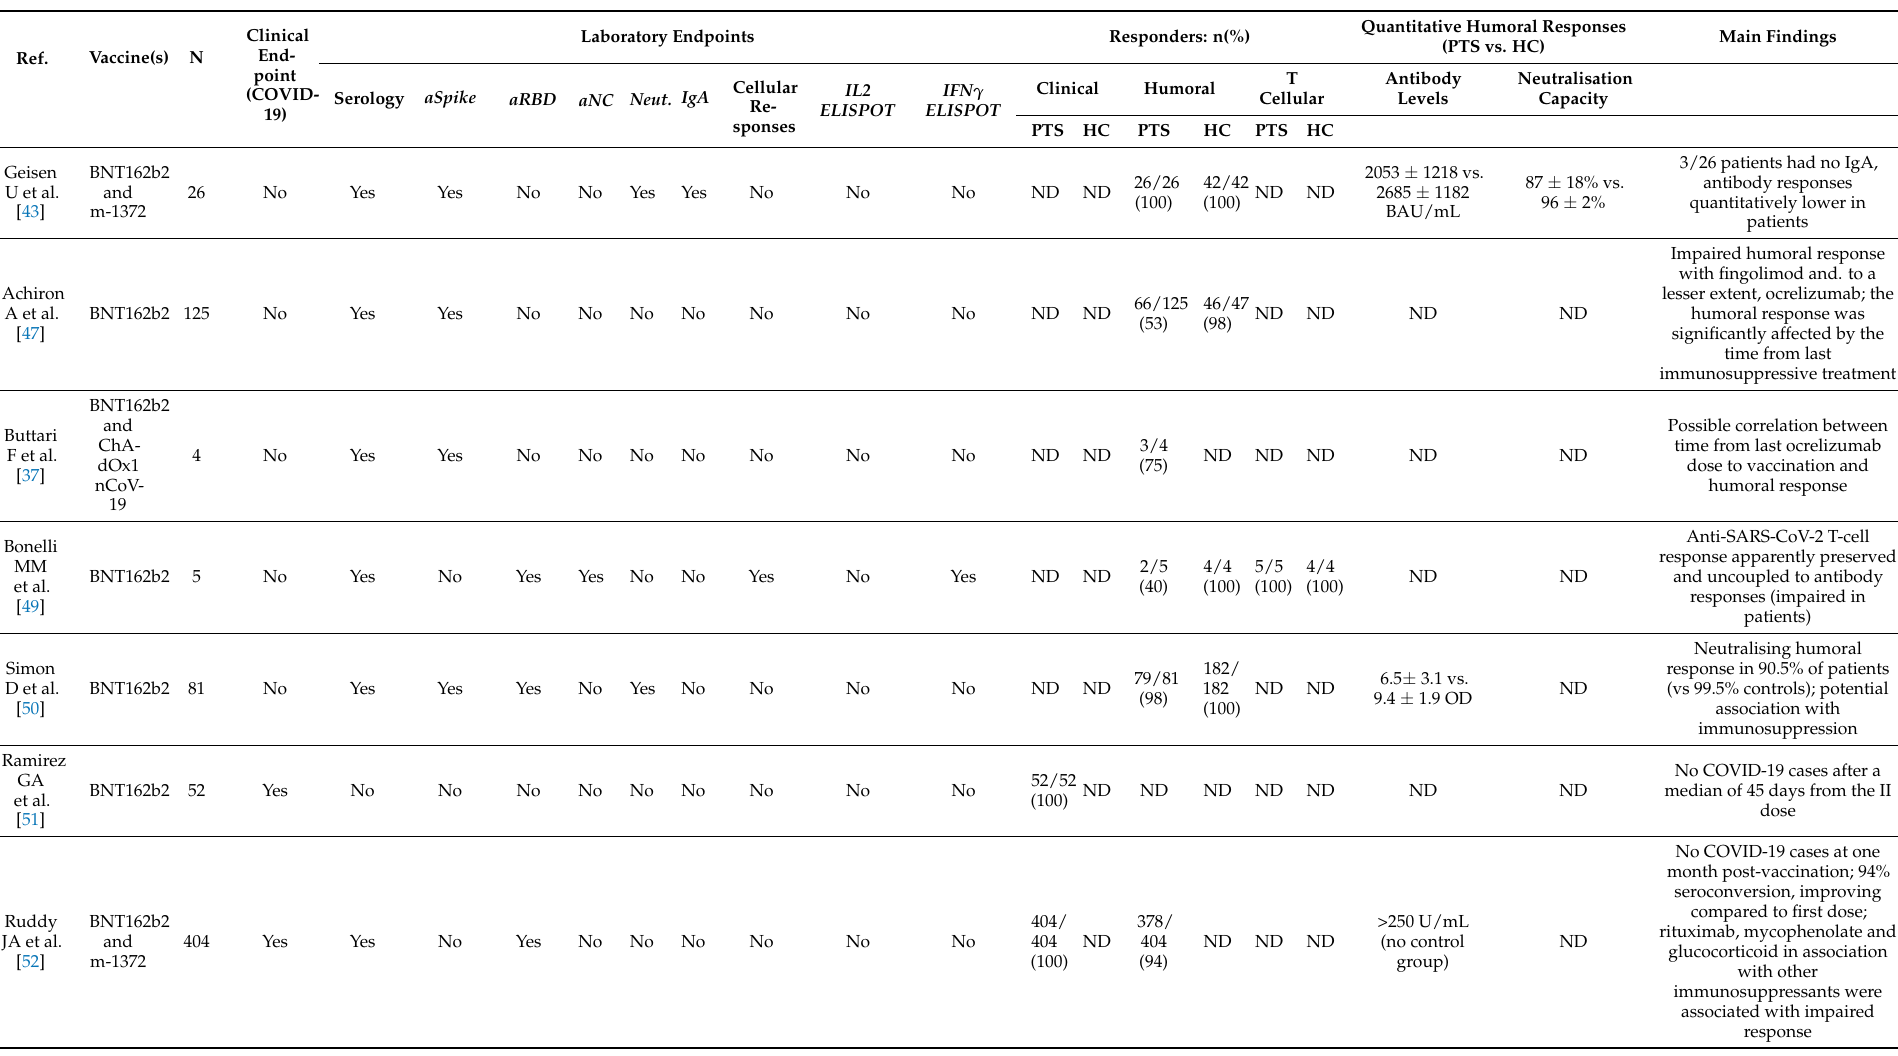
Table 4. Efficacy of vaccination in patients with autoimmune